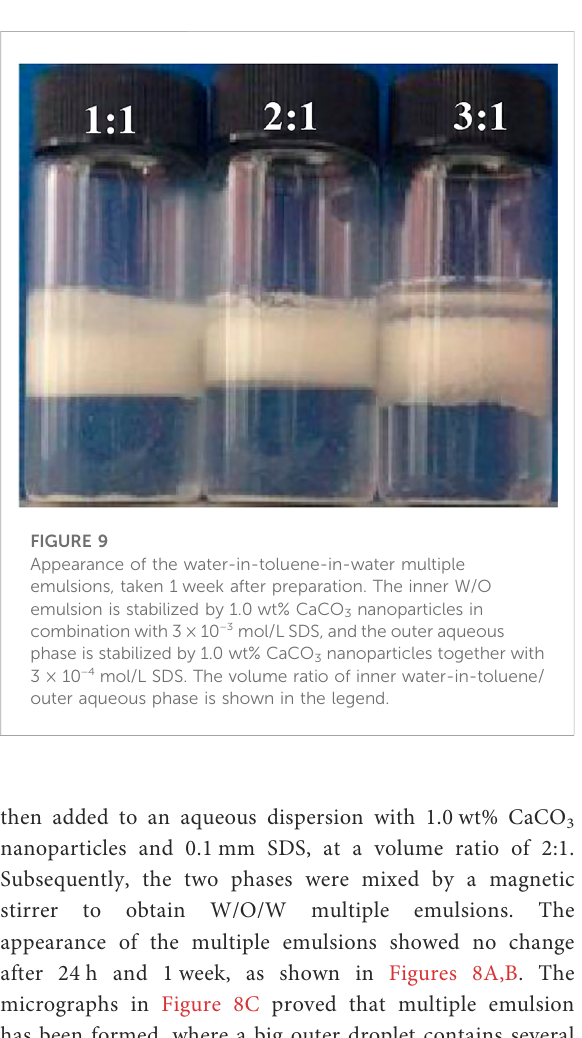
micrographs in Figure 7 show that the average droplet sizes of O/W (1) and W/O emulsions have little difference but are much bigger than those stabilized by SDS alone and of O/W (2) emulsions, which suggests that both O/W (1) and W/O emulsions are stabilized by the in situ hydrophobized particles instead of SDS molecules, while O/W (2) emulsions are stabilized mainly by SDS, where the concentration is over its CMC.